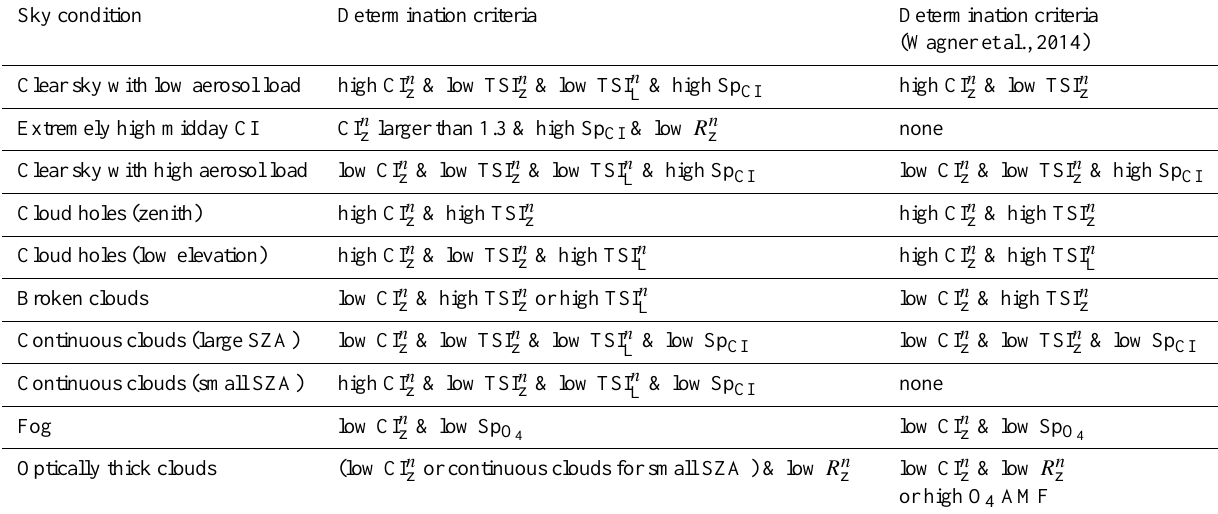
Table 2. Conditions used for the cloud classification scheme for MAX-DOAS observations at Wuxi. The abbreviations of the quantities are the same as in Table